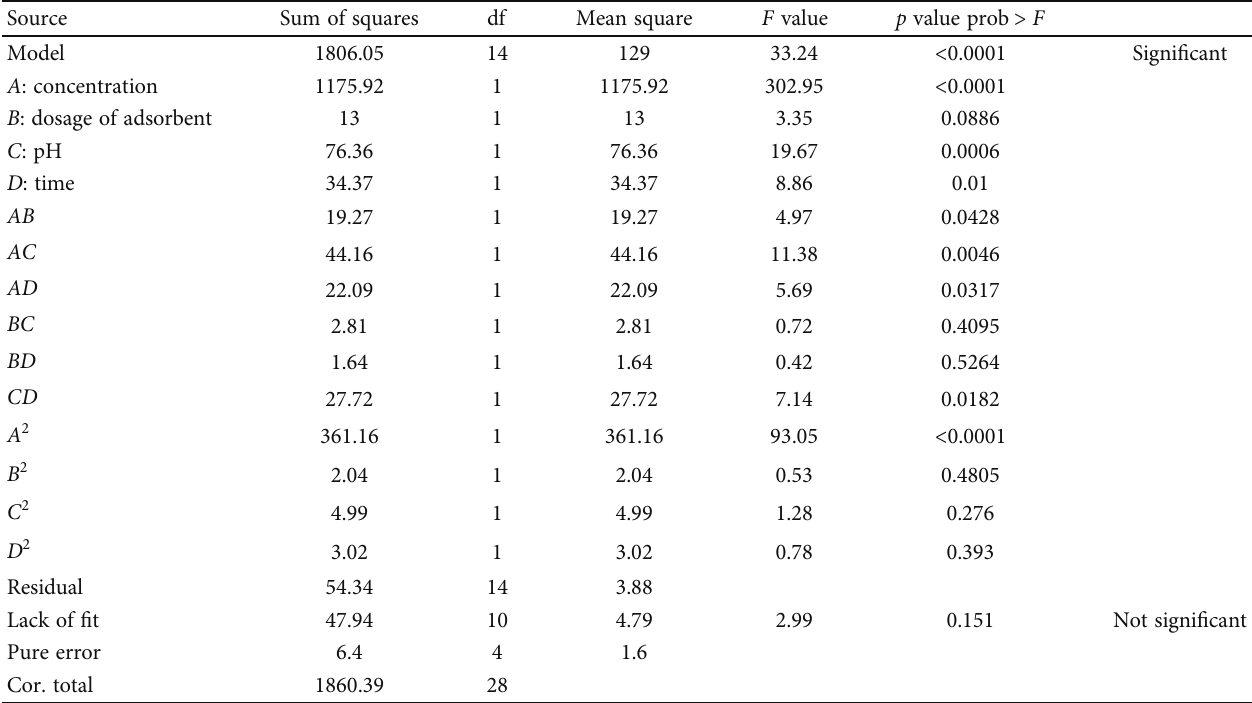
Table 4: Response surface quadratic model for adsorption of Congo red dye on breadfruit leaf biochar adsorbent: ANOVA results. Source Sum of squares df